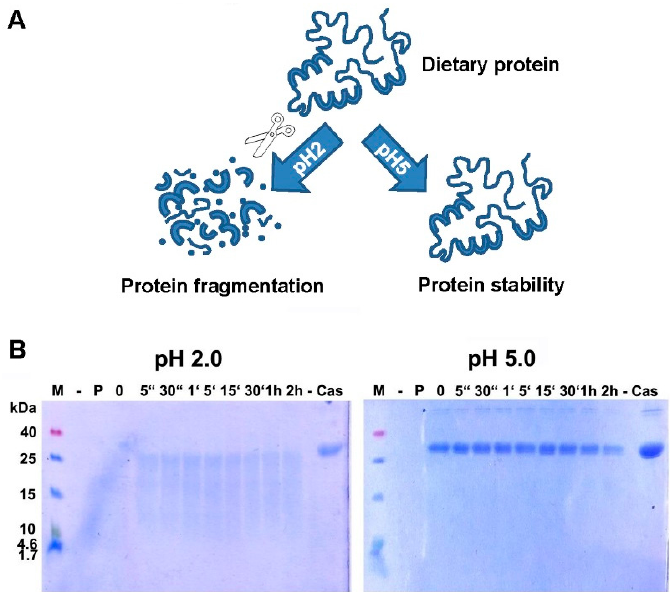
Figure 1. ( A ) Digestion of proteins is hampered when pH increases. Proteins, as part of the daily diet, are digested at low pH and broken down into smaller fragments, whereas a higher pH blocks proper digestion. The resulting bigger fragments or proteins are more easily recognized by the immune system, leading to an increased risk for sensitization or allergic reactions. ( B ) Digestion of α -casein in vitro is hampered when pH increases. Casein was readily broken down by enzymatic digestion with pepsin at pH 2.0, but remained totally intact even after 2 h of incubation with enzyme at pH 5.0. M: molecular weight marker; -: empty lane; P: pepsin; 0: no incubation time, reaction stopped